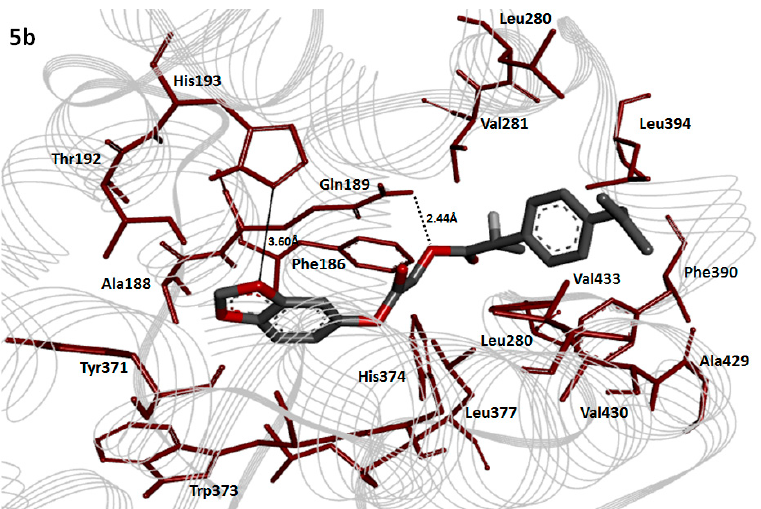
Figure 5. Docking interactions of ( 5b ) with receptor. The COX-2 protein chain is highlighted in light grey color in wire format. The dark grey color showed the ligand structure while the embedded red colors showed oxygen moiety. The binding pocket interacted residues are highlighted in dark red color and black dotted lines justify the hydrogen bondings. Two hydrogen bonds were observed with GLN189 and HIS193 at a distance 2.44 and 3.60 Å, respectively.